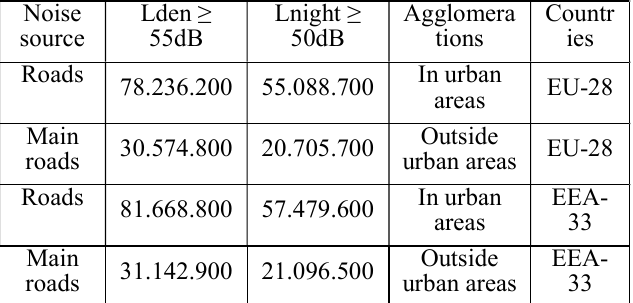
Table 1. Number of people exposed to average day-evening- night noise level (Lden) ≥ 55 dB in Europe